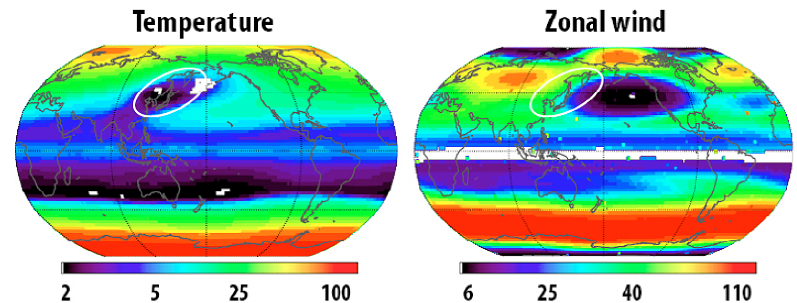
Figure 1. Annual cycle amplitudes of temperature (left) and zonal wind (right) at 30hPa. The non-linear colour scale used represents the square root of the wavelet power in K for temperature and in ms − 1 for zonal